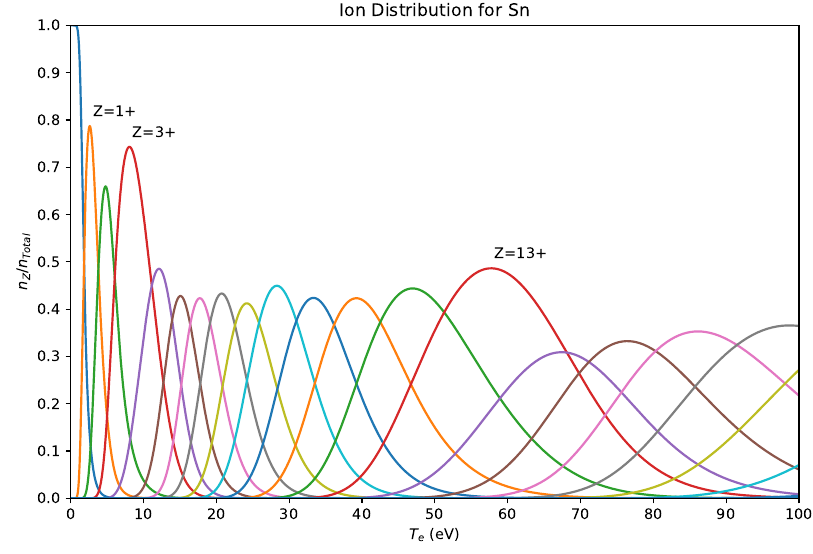
Figure 1. A Sn ion distribution generated using the traditional CR model by Colombant and Tonon [5], with different ion stages denoted by the different colored curves and the 1 + , 3 + , and 13 + ion stages